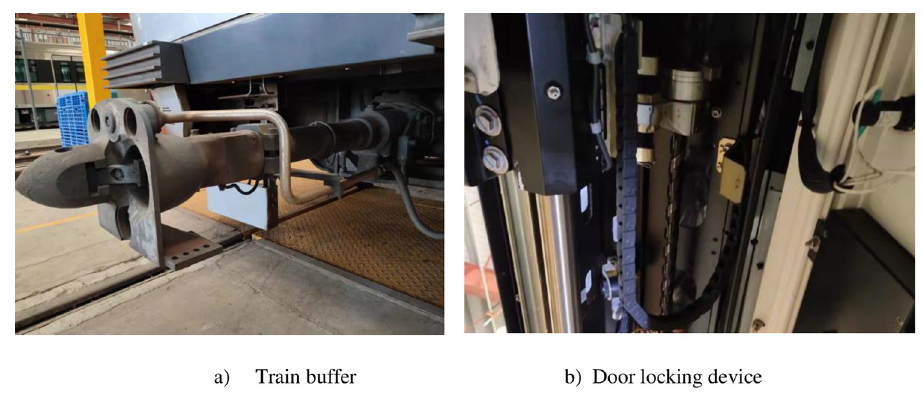
Fig 1. Photo of the Dalian metro scene. a) Train buffer, b) Door locking